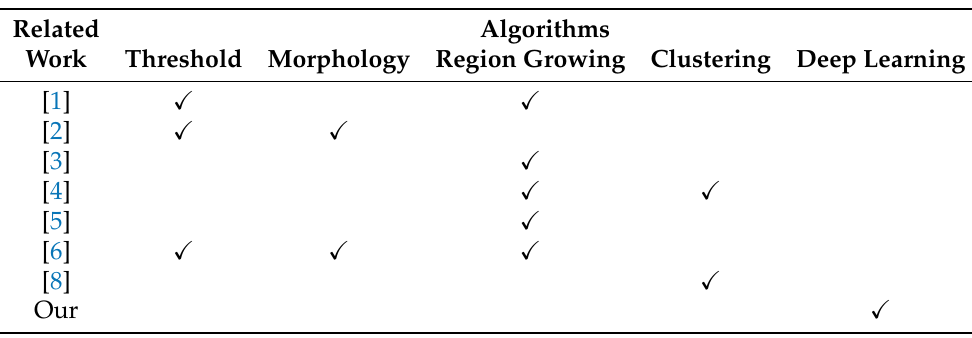
Table 1. Related